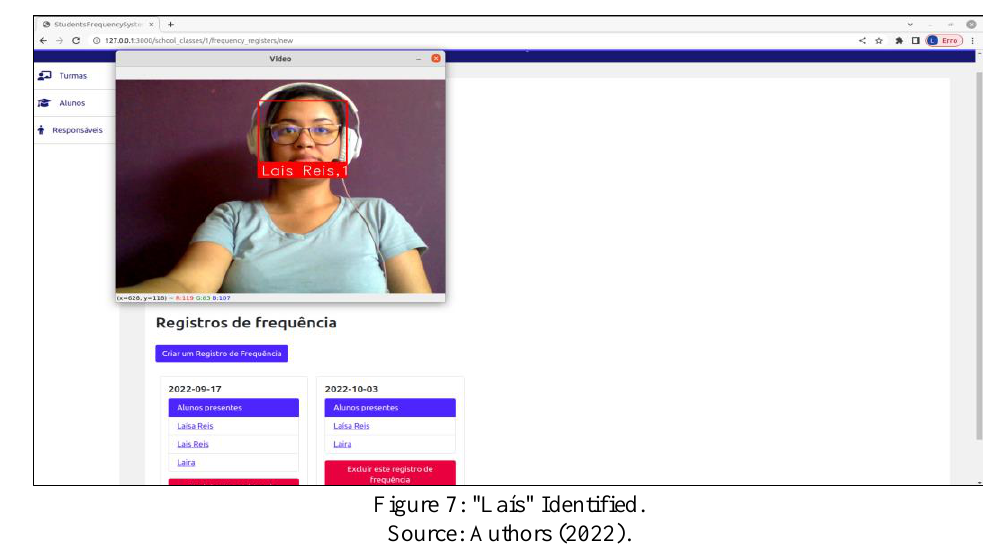
Figure 7: "Laís" Identified.